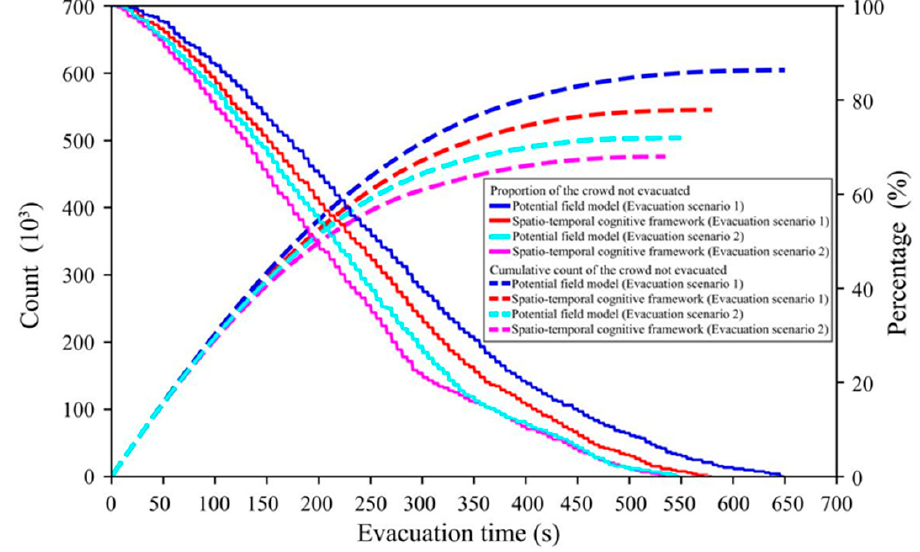
Figure 12. Individual subjectively estimated cost and cumulative cost of the crowd in different evacuation scenarios.